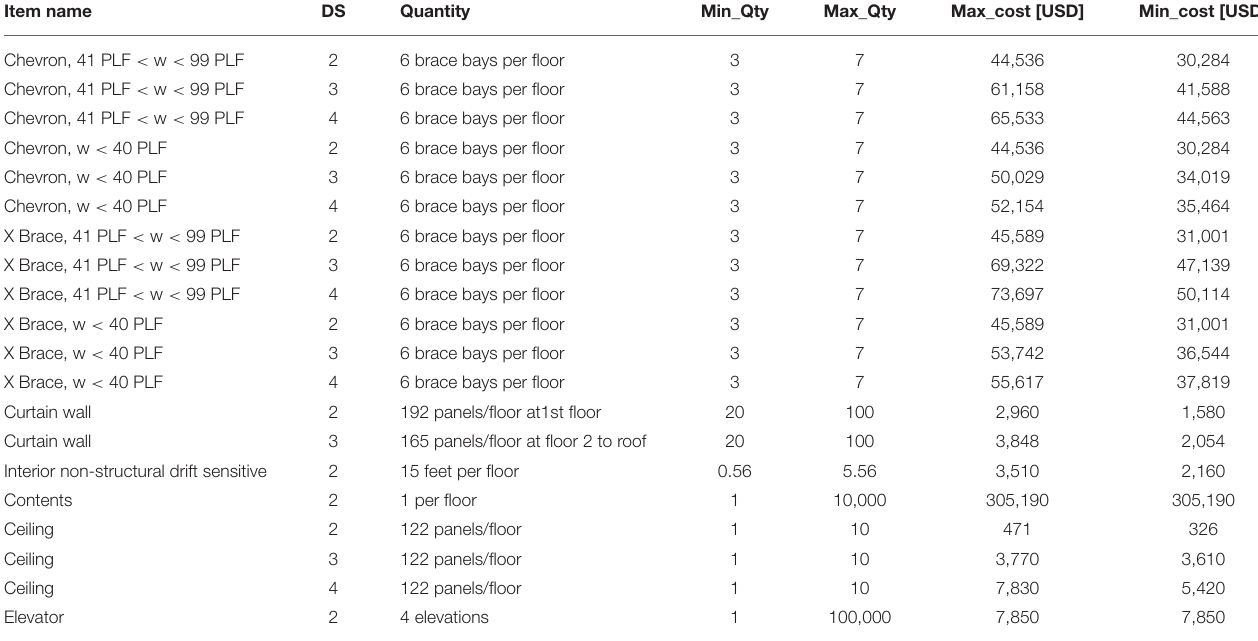
TABLE 6 | Repair quantities and unit cost of repair items.